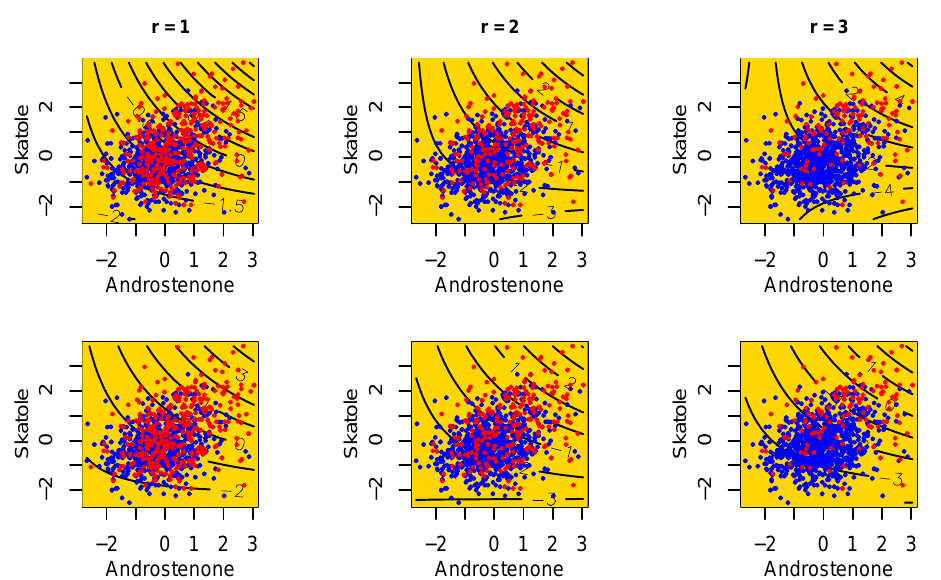
Figure 2. Fitted log-odds of sensory perception of boar taint under NPOM ( upper row) and POM ( lower row), having (log-transformed, standardized) androstenone and skatole, plus interaction as explanatory variables. Each column denotes the log-odds of panelist G’s rating falling into the upper categories with cut-point r = 1,2,3 (column 1 to 3). The data observed are drawn as colored dots: red, if Y i > r ; blue, if Y i ≤ r .